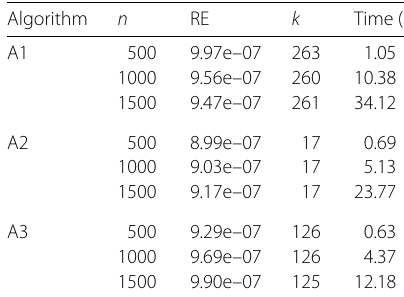
Table 1 Performance of A1, A2, and A3 with different n Algorithm